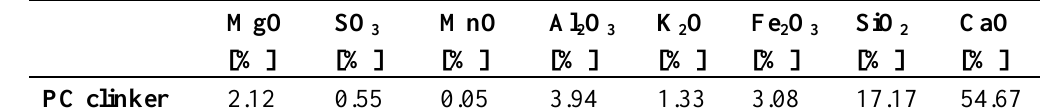
Table 1. Portland cement clinker chemical composition based on a wavelength dispersive X-ray spectrometry (WDS) microprobe investigation.